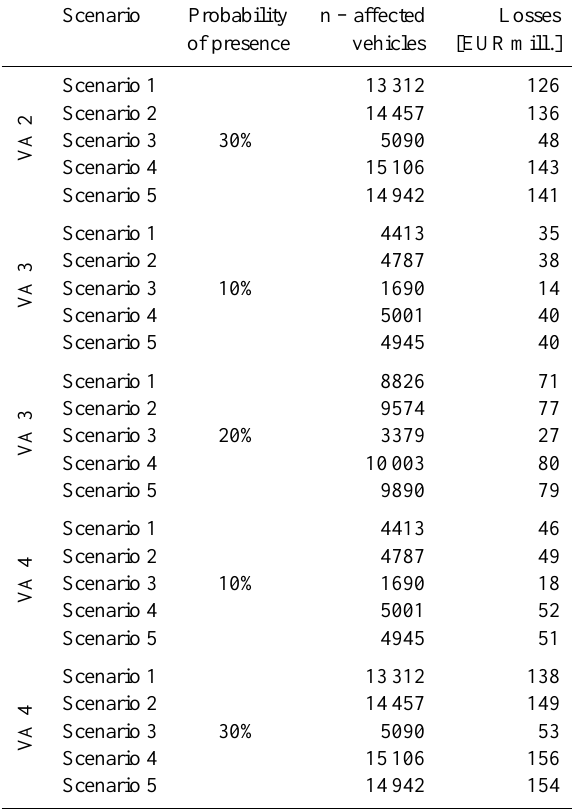
Table 6. Overview of estimated ESL to vehicles for the different scenarios